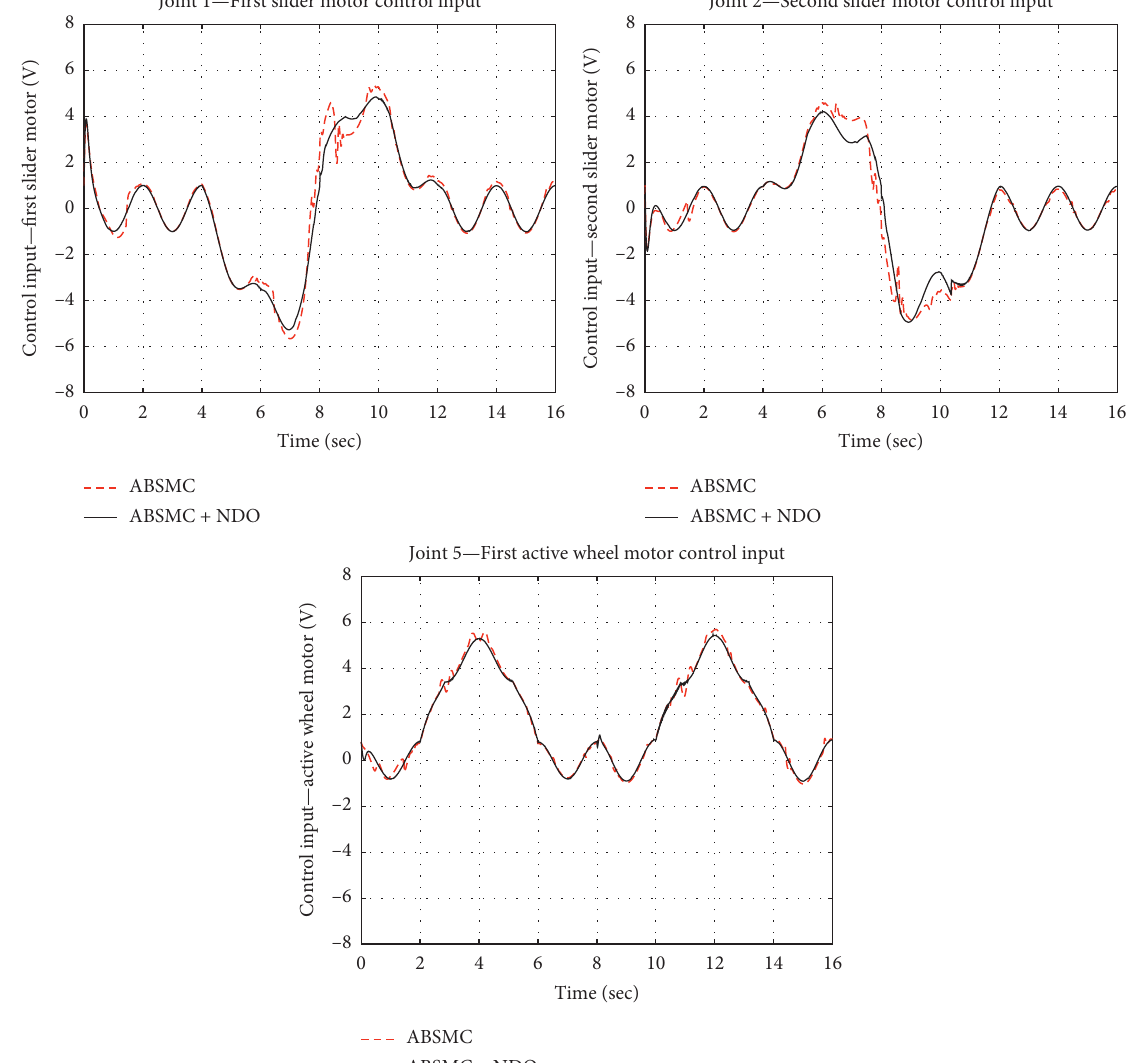
Figure 5: Control input of each